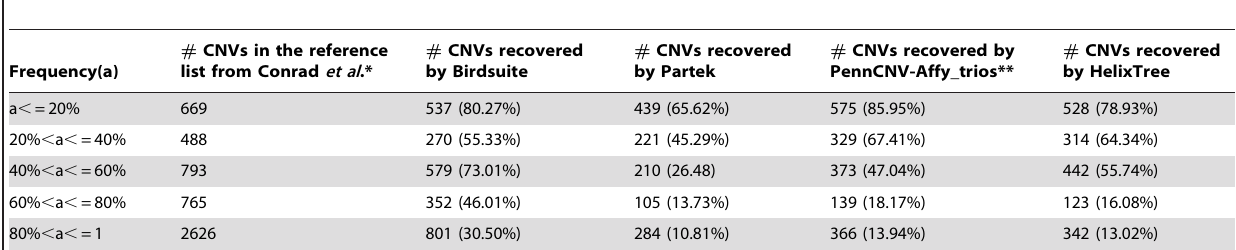
Table 3. The average recovery rates of each of the CNV-calling programs depending on CNV frequency based on data by Conrad et al . in 90 CEU samples.